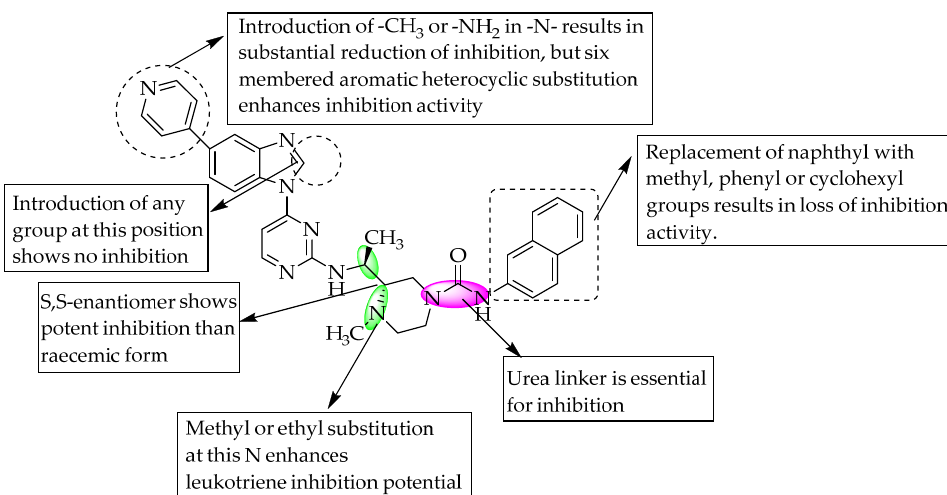
Figure 21. SARs of pyrimido-benzimidazoles.